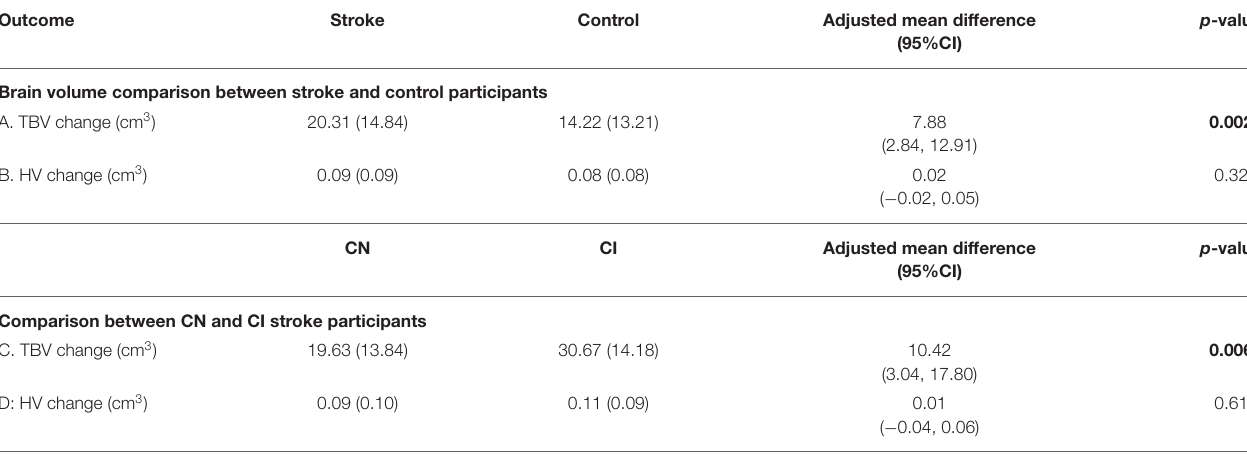
TABLE 4 | Primary and secondary hypotheses results: linear regression analyses.